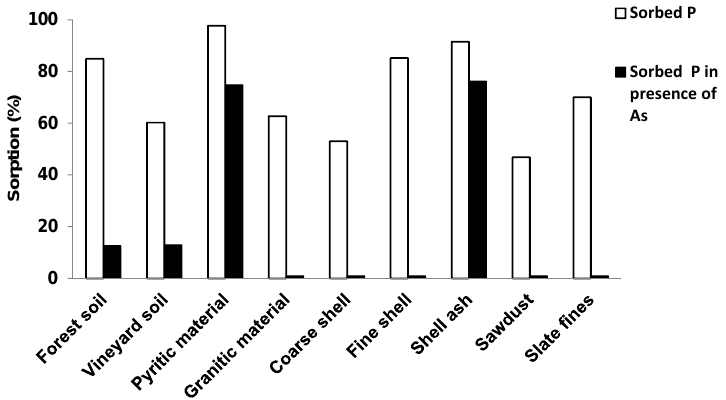
− 1 is added, showing